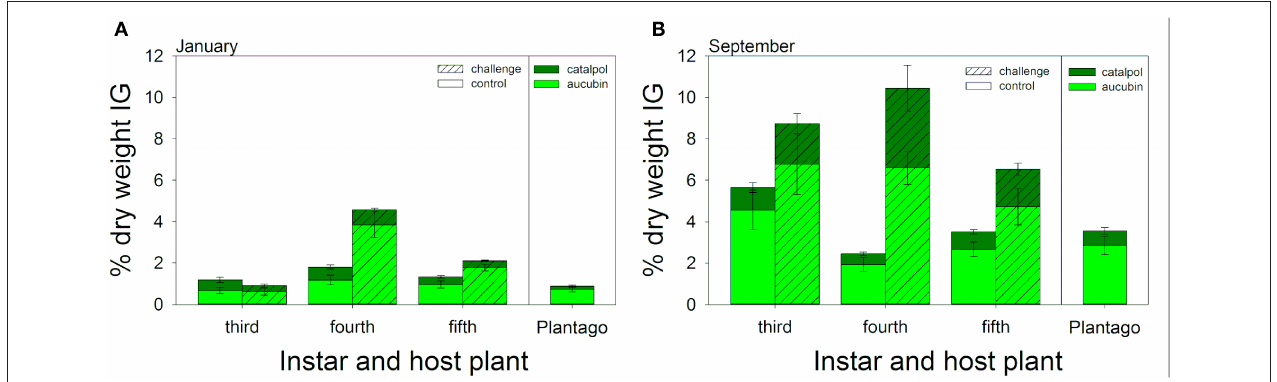
FIGURE 4 | Composite figures illustrate multiple significant interactions between caterpillar instar and immune challenge on both total iridoid glycoside sequestrations (bar height) and the proportion of sequestered IGs that was catalpol (dark green). Results from the January (A) and September (B) experiments are included: right panels illustrate chemistry of sampled Plantago used for feeding during each experimental period. Bars represent ± 1 SE. See Results for statistical tests.